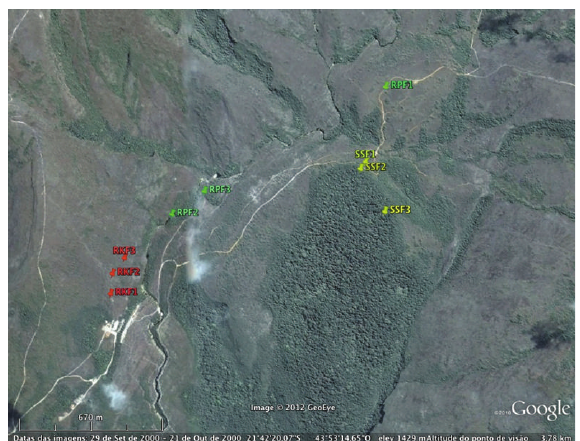
Figure 1: Parque Estadual do Ibitipoca (PEIb) in Minas Gerais State, Brazil. Red pins: Rocky Fields (RKF); Green pins: Riparian Forest (RPF); Yellow pins: Semidecidous Secondary Forest (SSF). Font: Google Earth,